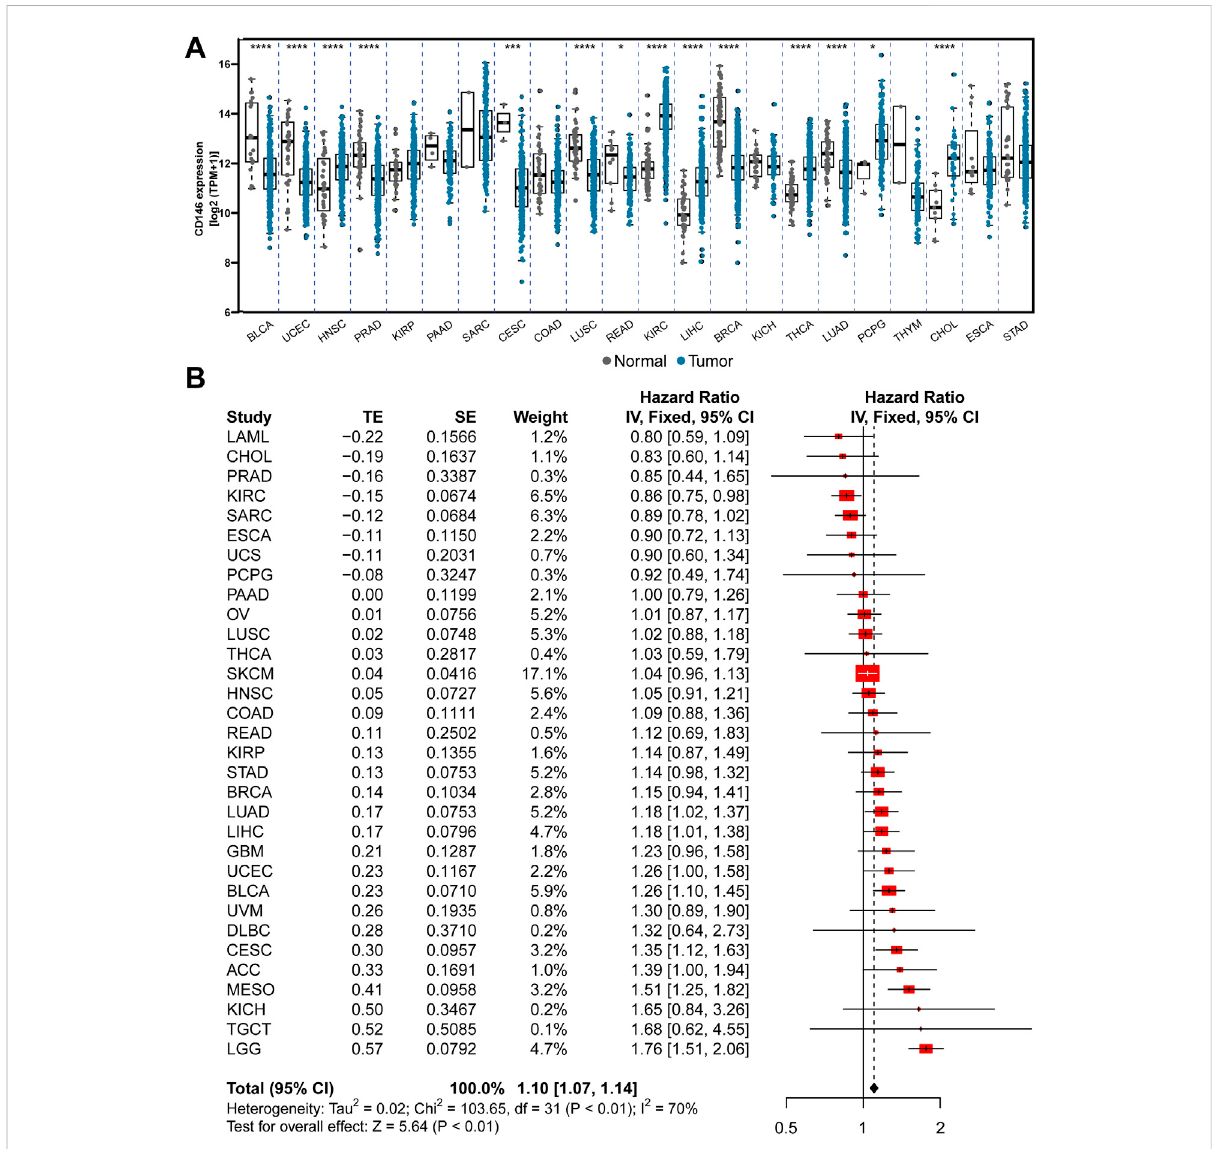
FIGURE 1 CD146 is increased in tumor tissue and predicts poor prognosis among pan-cancer. (A) The differential expression of CD146 in 22 types of tumor and adjacent normal tissues. (B) Meta-analysis revealed the integrative hazard risk of CD146 to